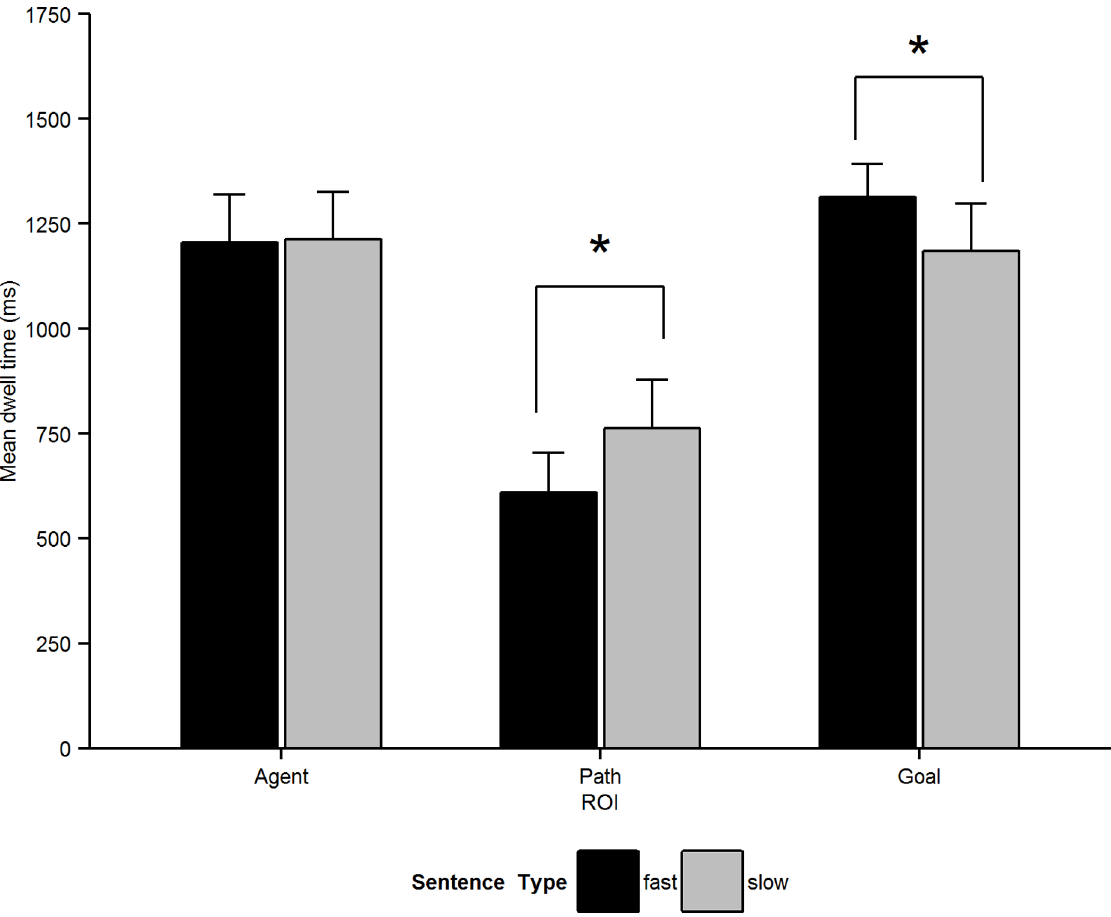
Figure 3. Mean total dwell time (total looking time per trail from verb onset to sentence offset) for the Agent, Path and Goal ROI. Error bars indicate 95% within-participants confidence intervals .